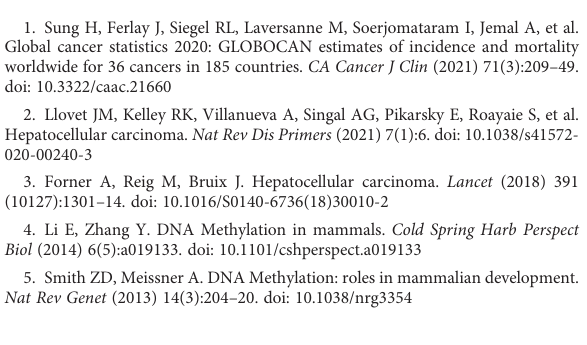
SUPPLEMENTARY FIGURE 2 The GSVA analysis of DNA methylaiton regulators-related patterns between pattern (A – C) and pattern (B, C) . SUPPLEMENTARY FIGURE 3 The unsupervised clustering of DNA methylation regulators-related DEGs and consensus matrix heatmaps. (A) Venn diagram of DEGs among three DNA methylation regulators-related patterns. (B) CDF Delta area curve. (C) The consensus matrix heatmaps for k = 2, and k = 4-9. SUPPLEMENTARY FIGURE 4 Characteristics of eight genes in the risk model. (A) The prognosis of eight genes in HCC patients. (B – I) The expression differences of eight genes in two risk groups. SUPPLEMENTARY FIGURE 5 Landscape of genetic variations and transcriptional expression of eight genes. (A) The expression level of eight genes between different risk groups with clinical features. (B) 7 of the 364 patients occurred genetic variations of eight genes with 1.92% mutation frequencies. (C) The locations of CNV variations in eight genes on 23 chromosomes. (D) The frequency of CNV gain or loss among eight genes. SUPPLEMENTARY FIGURE 6 Strati fi cation analysis of the DMRegs_score in HCC. (A, B) Age (age ≤ 60 and age > 60 years old). (C, D) Gender (female and male). (E, F) Tumor stage (I-II or III-IV). SUPPLEMENTARY FIGURE 7 The relationship between DMRegs_score and therapeutic sensitivity. SUPPLEMENTARY FIGURE 8 The univariate and multivariate cox analysis of DMRegs_score in validating